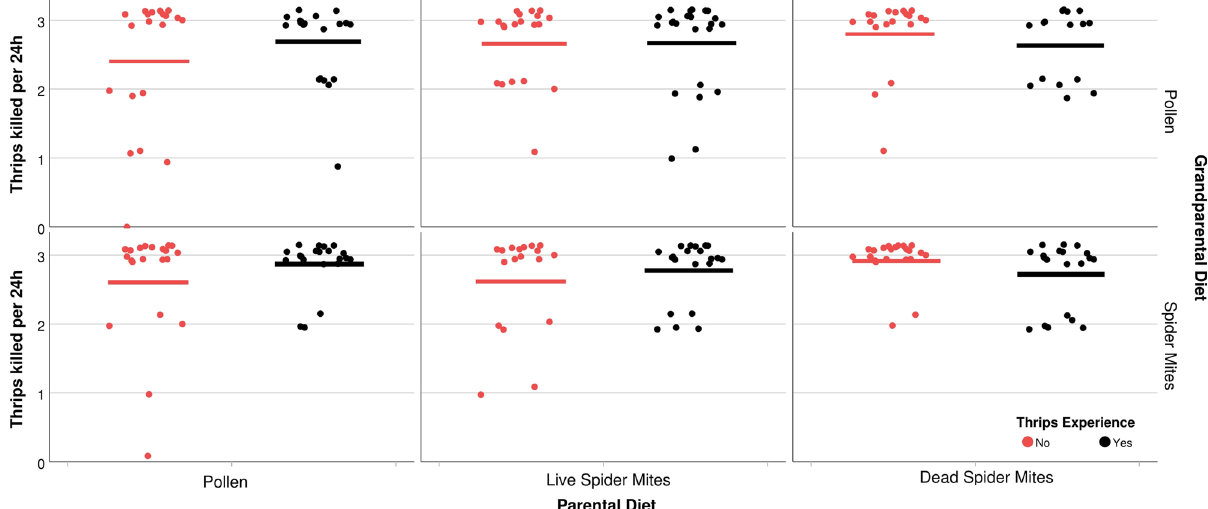
Fig. 5 Total predation rate. Number of thrips killed within 24 h (dots represent individual experimental animals; short horizontal bars represent the means) by mated A. swirskii females, kept singly inside acrylic cages and presented three 1st instar thrips, F. occidentalis . Predatory mite females had experienced thrips early in life or not ( + or − ) and were the progeny of parents fed Typha pollen (P), life spider mites (L), or dead spider mites (D), and grandparents fed Typha pollen (P) or live spider mites (L). The numbers of replicates ( n ; independent experimental animals) within treatments (sequence in treatment acronyms is grandparental diet, parental diet, early life experience by progeny) are 21 (LP + ), 21 (LP − ), 21 (LL + ), 18 (LL − ), 20 (LD + ), 22 (LD − ), 20 (PP + ), 20 (PP − ), 23 (PL + ), 20 (PL − ), 16 (PD + ), 19 (PD − ). The interaction between parental diet and thrips experience had a signi fi cant effect (GLM, P < 0.05; see Table 1 for complete statistical